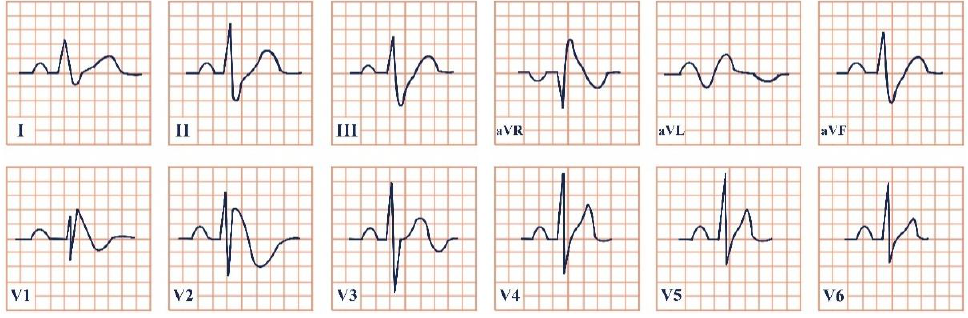
Figure 8. Electrocardiogram aspect in Brugada syndrome type